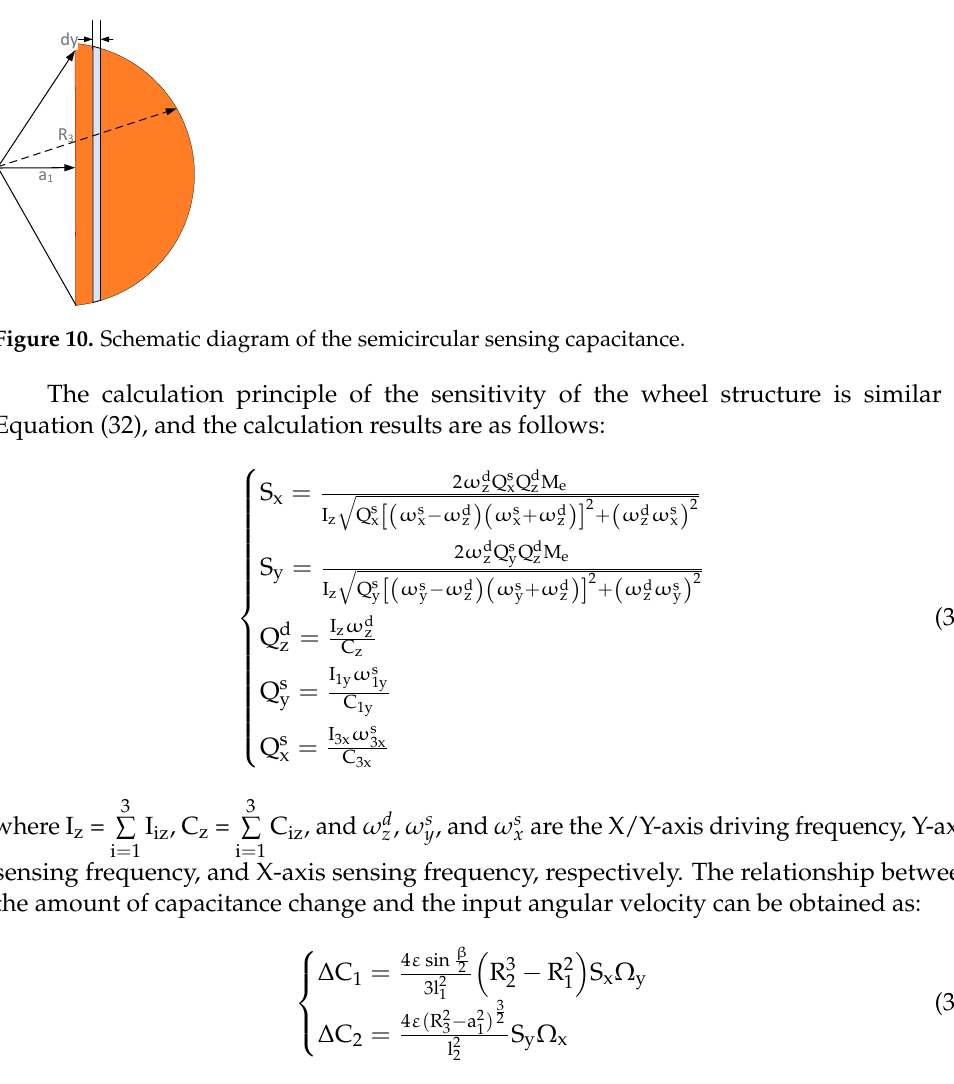
where R 3 represents the outer radius of the disc, a 1 represents the vertical distance between the origin and the disk-shaped electrode, θ y represents the central angle corresponding to the disc, and l 2 represents the initial distance between the upper and lower plates.